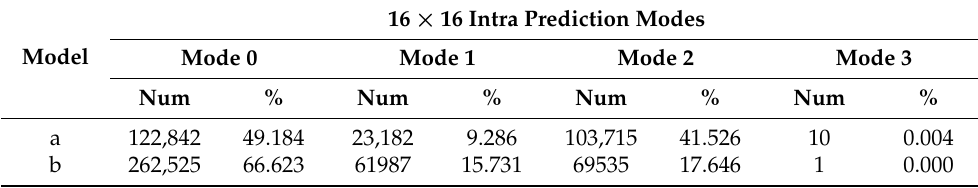
Table 9. One example of peculiar results in some H.264 hardware video encoders.